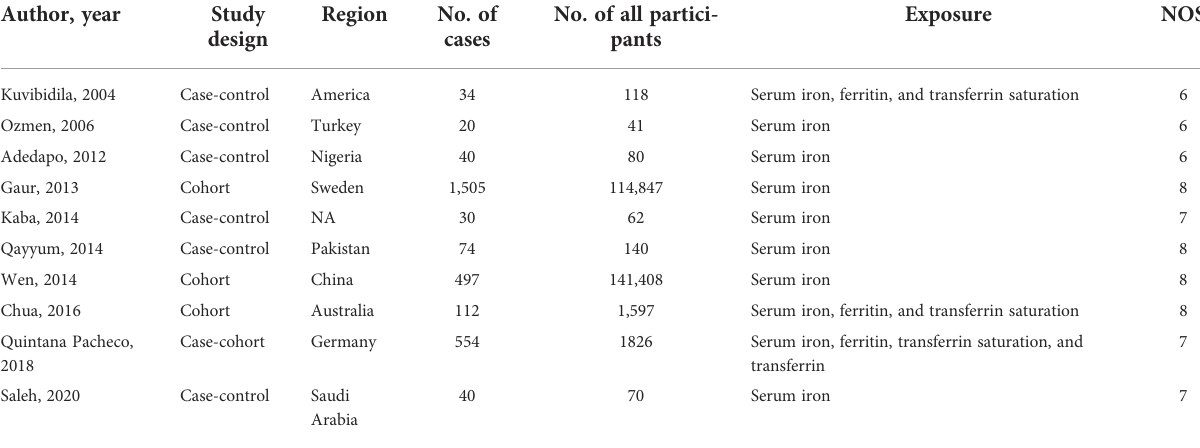
TABLE 2 Detailed information about the included studies in the meta-analysis.